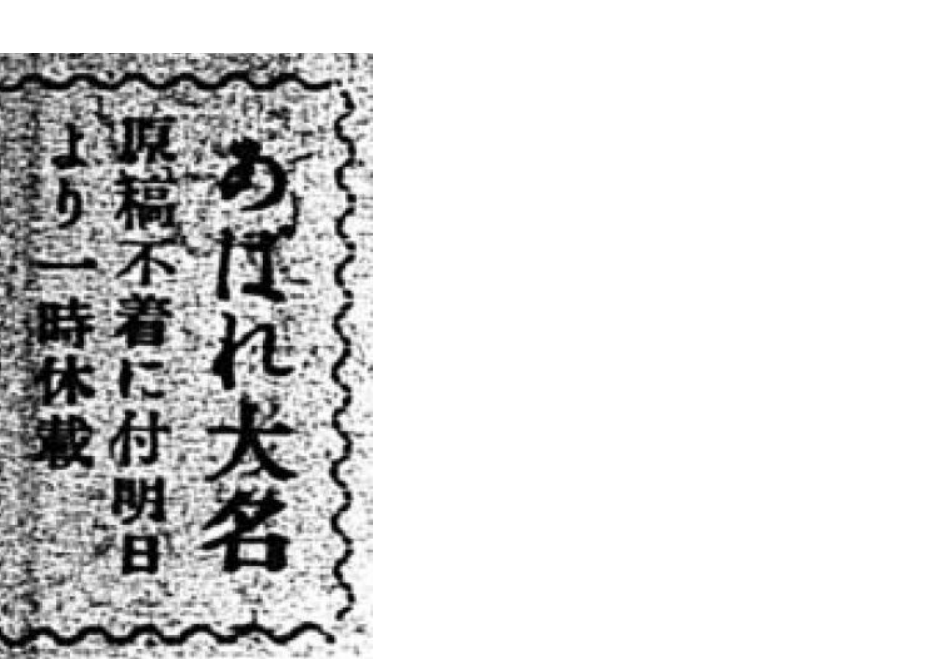
Figure 8. Announcement about temporary suspension of The Violent Daimyo . Burajiru jihō 23 April 1940. Image courtesy of the Hoji Shinbun Digital Collection.